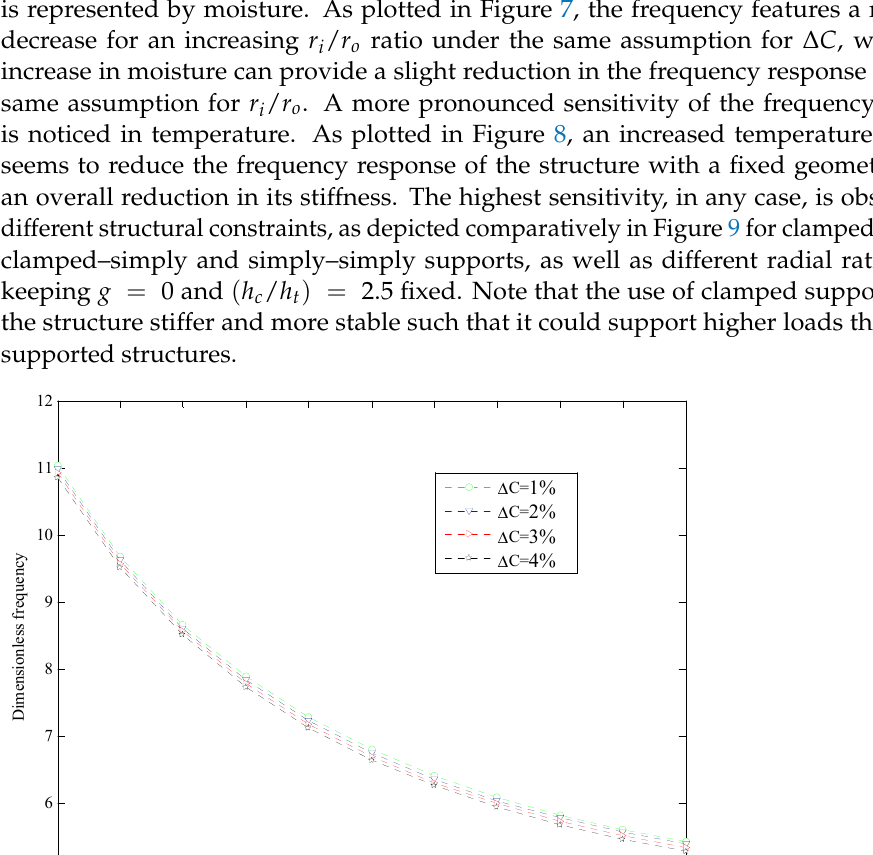
Figure 6. Dimensionless frequency versus power law index for different variations in radial ratio.